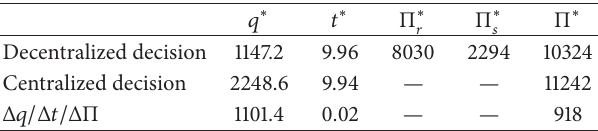
Table 1: Optimal decisions and profits in decentralized and central- ized systems.